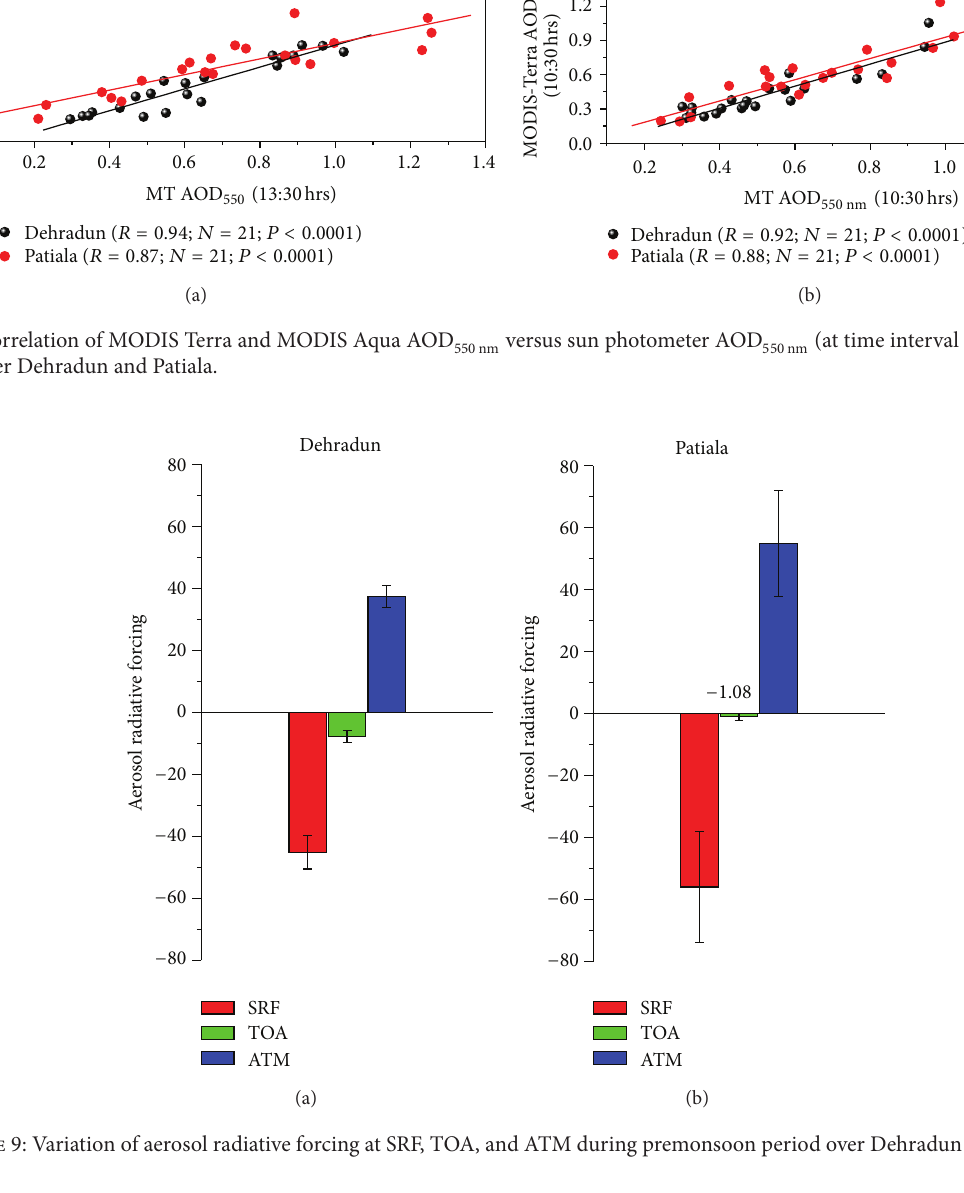
The analysis shows that the satellite derived AOD over Dehradun and Patiala is in good agreement ( R = 0.94; R =